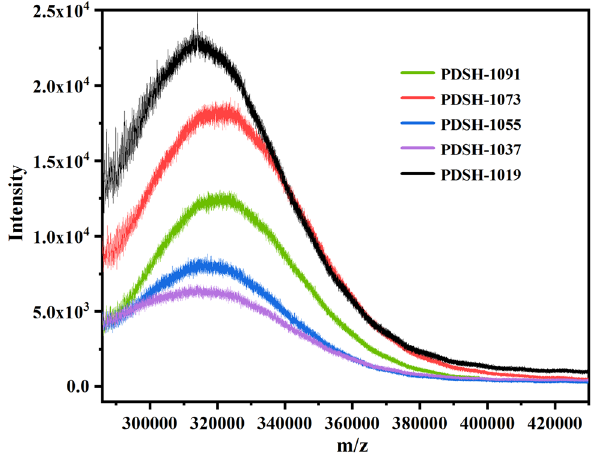
Figure 3: MALDI - TOF spectra of PDSH.